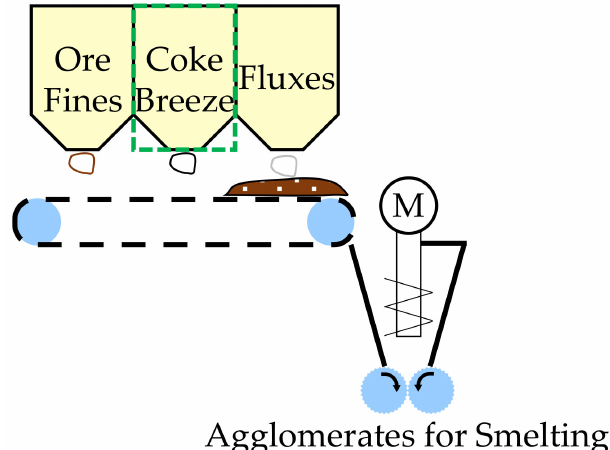
Figure 6. Schematic briquetting